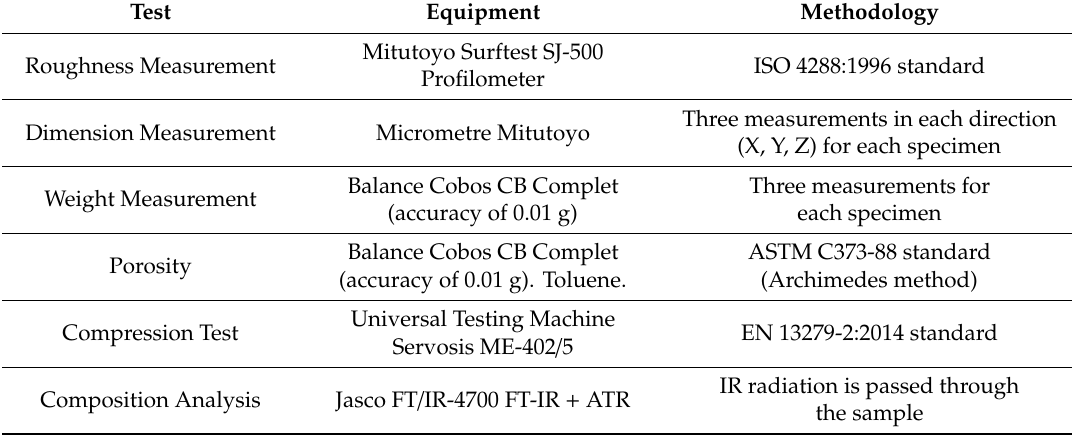
Table 2. Tests performed to analyse the e ff ect of heat treatments on CaSO 4 · 1 H 2 O specimens. 2 Test Equipment Methodology Mitutoyo Surftest SJ-500 Roughness Measurement ISO 4288:1996 standard Profilometer Three measurements in each direction Dimension Measurement Micrometre Mitutoyo (X, Y, Z) for each specimen Balance Cobos CB Complet Three measurements for Weight Measurement (accuracy of 0.01 g) each specimen Balance Cobos CB Complet ASTM C373-88 standard Porosity (accuracy of 0.01 g). Toluene. (Archimedes method) Universal Testing Machine Compression Test EN 13279-2:2014 standard Servosis ME-402 / 5 IR radiation is passed through Composition Analysis Jasco FT / IR-4700 FT-IR + ATR the